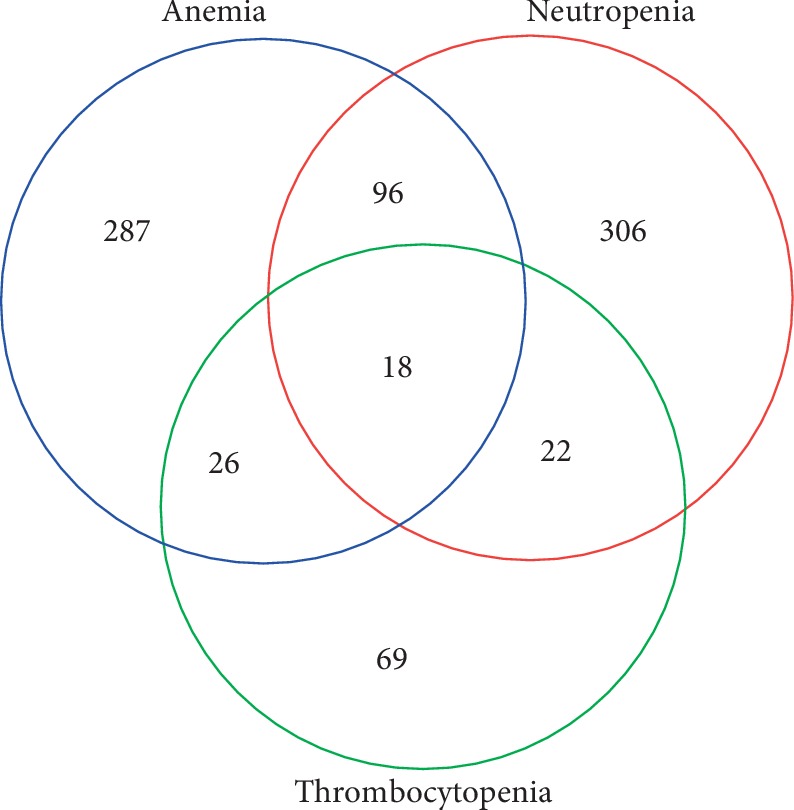
Distribution of cytopenia cases among the participants of the study.